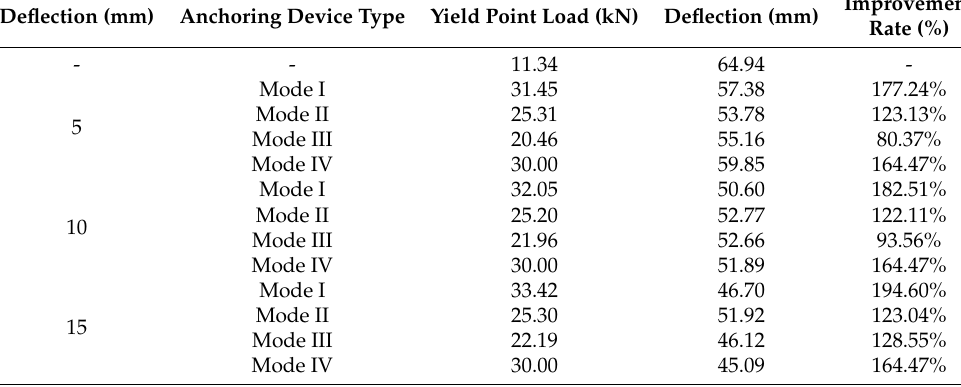
Table 2. Bearing capacity with various initial deflection.